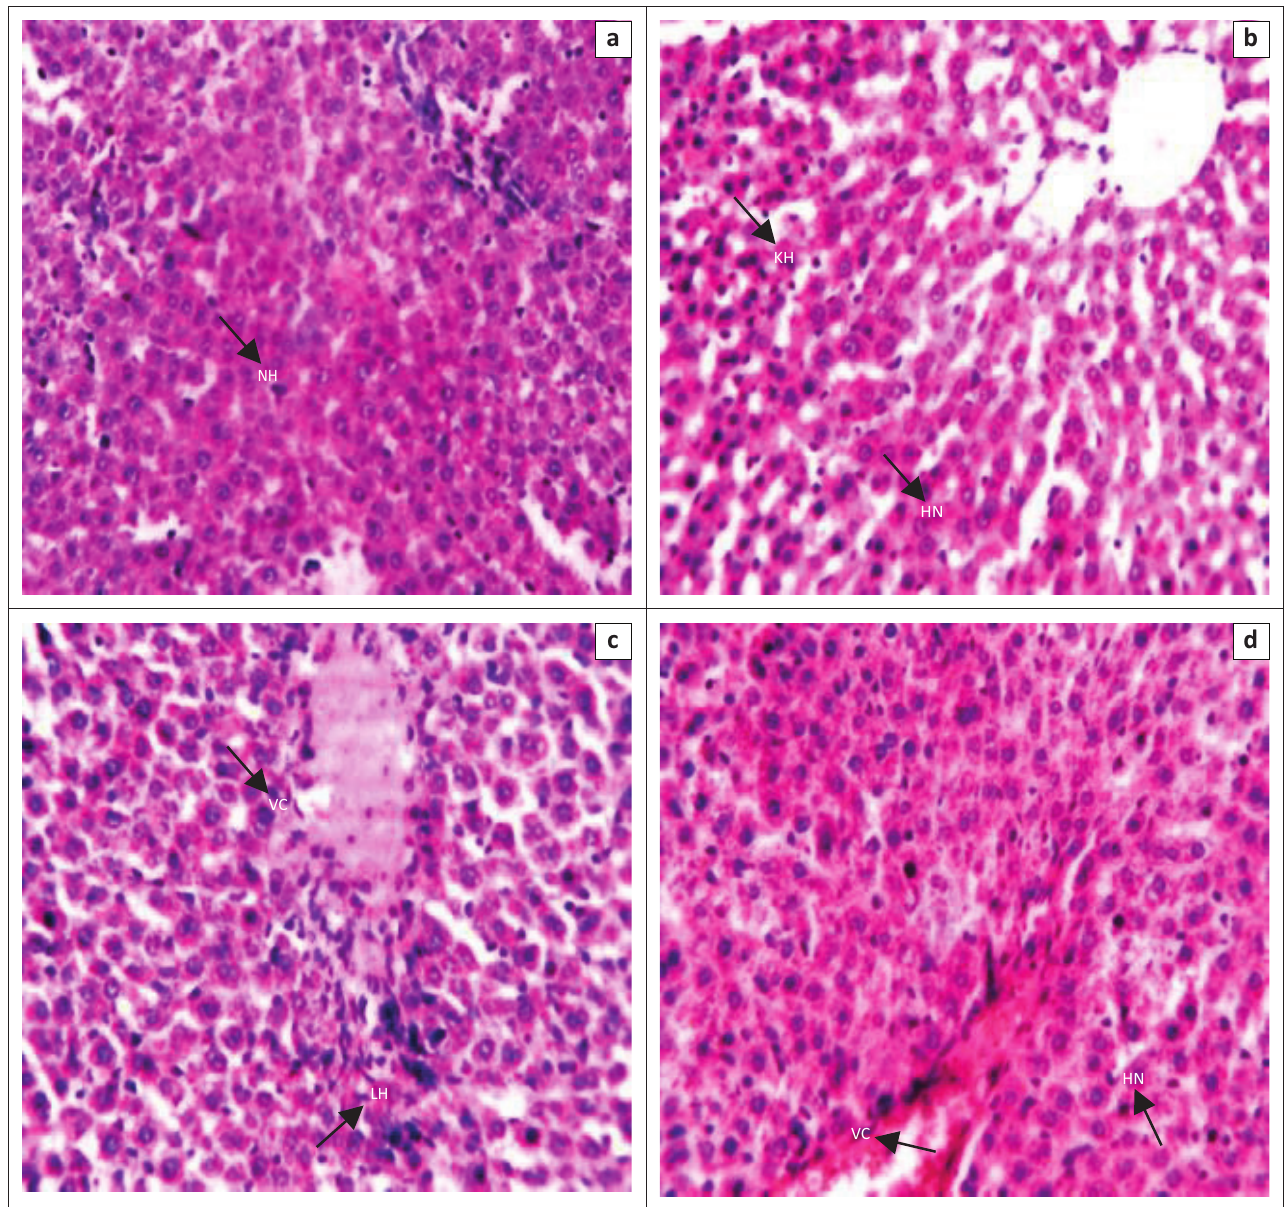
FIGURE 6: Photomicrograph from the liver section of (a) control group (1 mL/kg distilled water) shows the normal hepatocytes; (b) treated with 500 mg/kg methanol extract shows slight hepatocellular hyperplasia; (c) rat treated with 1000 mg/kg methanol extract shows vascular congestion with lymphocyte hyperplasia; (d) treated with 1500 mg/kg methanol extract shows vascular congestion with lymphocyte hyperplasia and slight hepatocellular necrosis (haematoxylin and eosin stain; original magnification ×